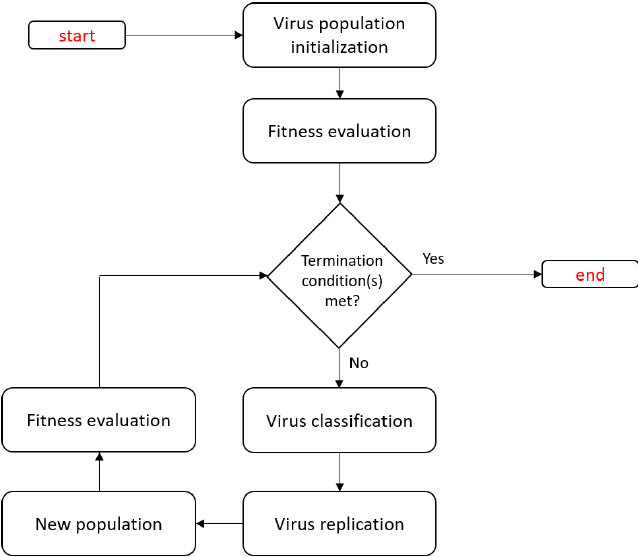
Figure 3. Virus-based